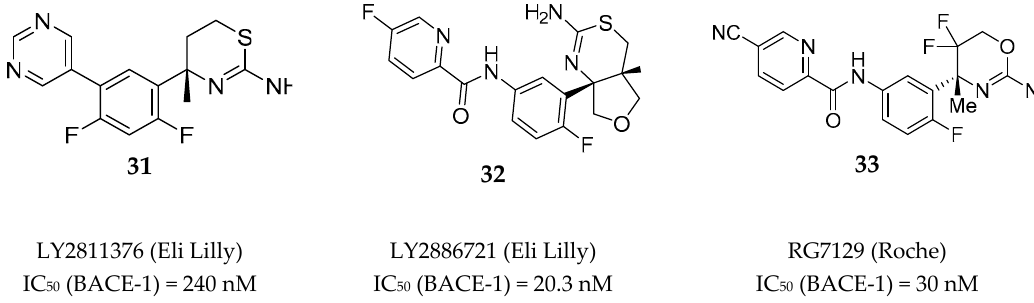
Figure 28. Aminothiazines 31–32 and aminooxazine 33 based compounds evaluated in clinical trials.